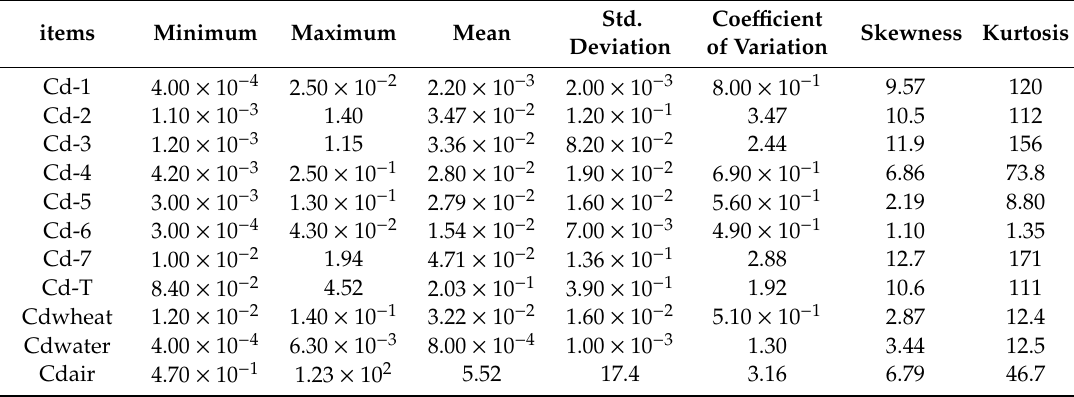
Table 2. Concentration statistics for each medium and seven types of fractions of Cd elements (unit: mg / kg, except for water: mg / L).